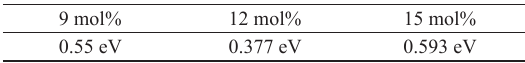
Table 7. Activation Energy measured from slope of above graphs in